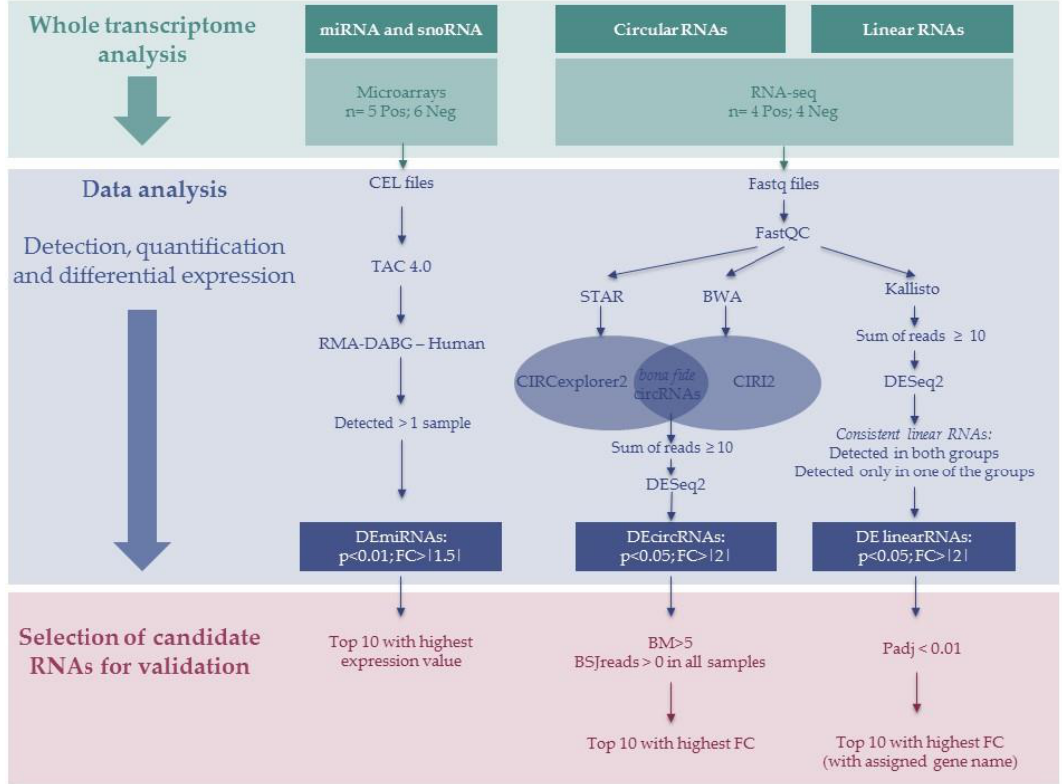
Figure 1. Summary of the study indicating profiling experiments, data analysis tools, filters and candidate selection criteria. Pos—positive. Neg—negative. DE—differentially expressed. FC—fold-